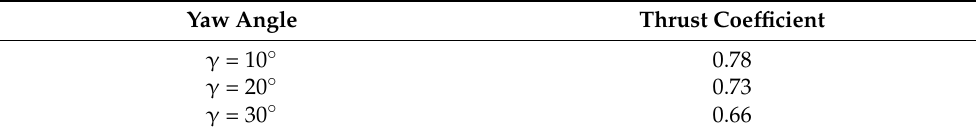
Table 1. Thrust coefficients of wind turbines under different yaw angles in the